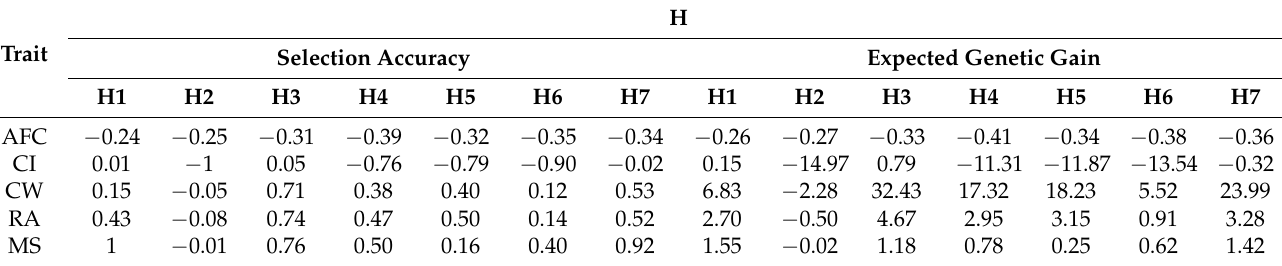
Table 8. Selection accuracies and expected genetic gains 1 .